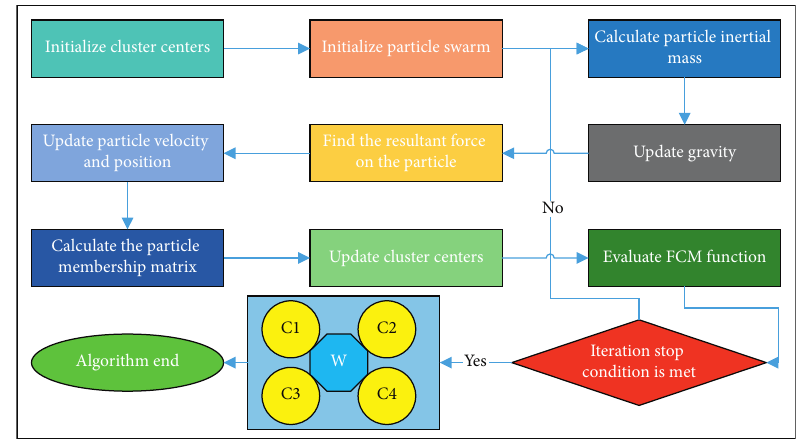
Figure 2: The FCM algorithm